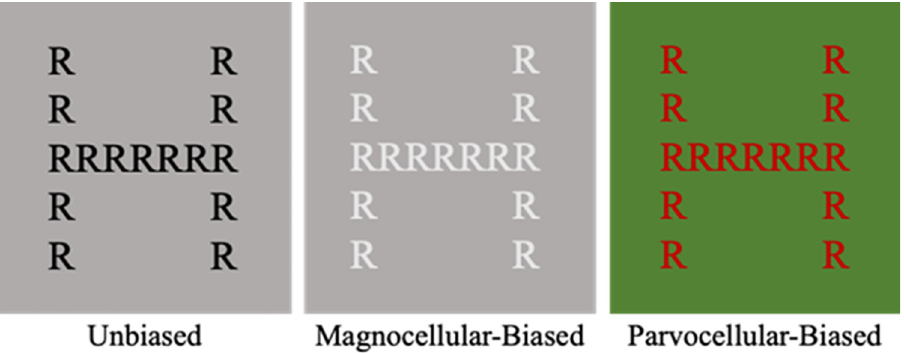
Fig 1. The three types of stimuli used to bias processing. This example shows incongruent stimuli in which the local letters (R) combine to form the global letter (H). The contrast and luminance properties of the magnocellular- and parvocellular-biased stimuli have been altered to make the stimuli more discernible to